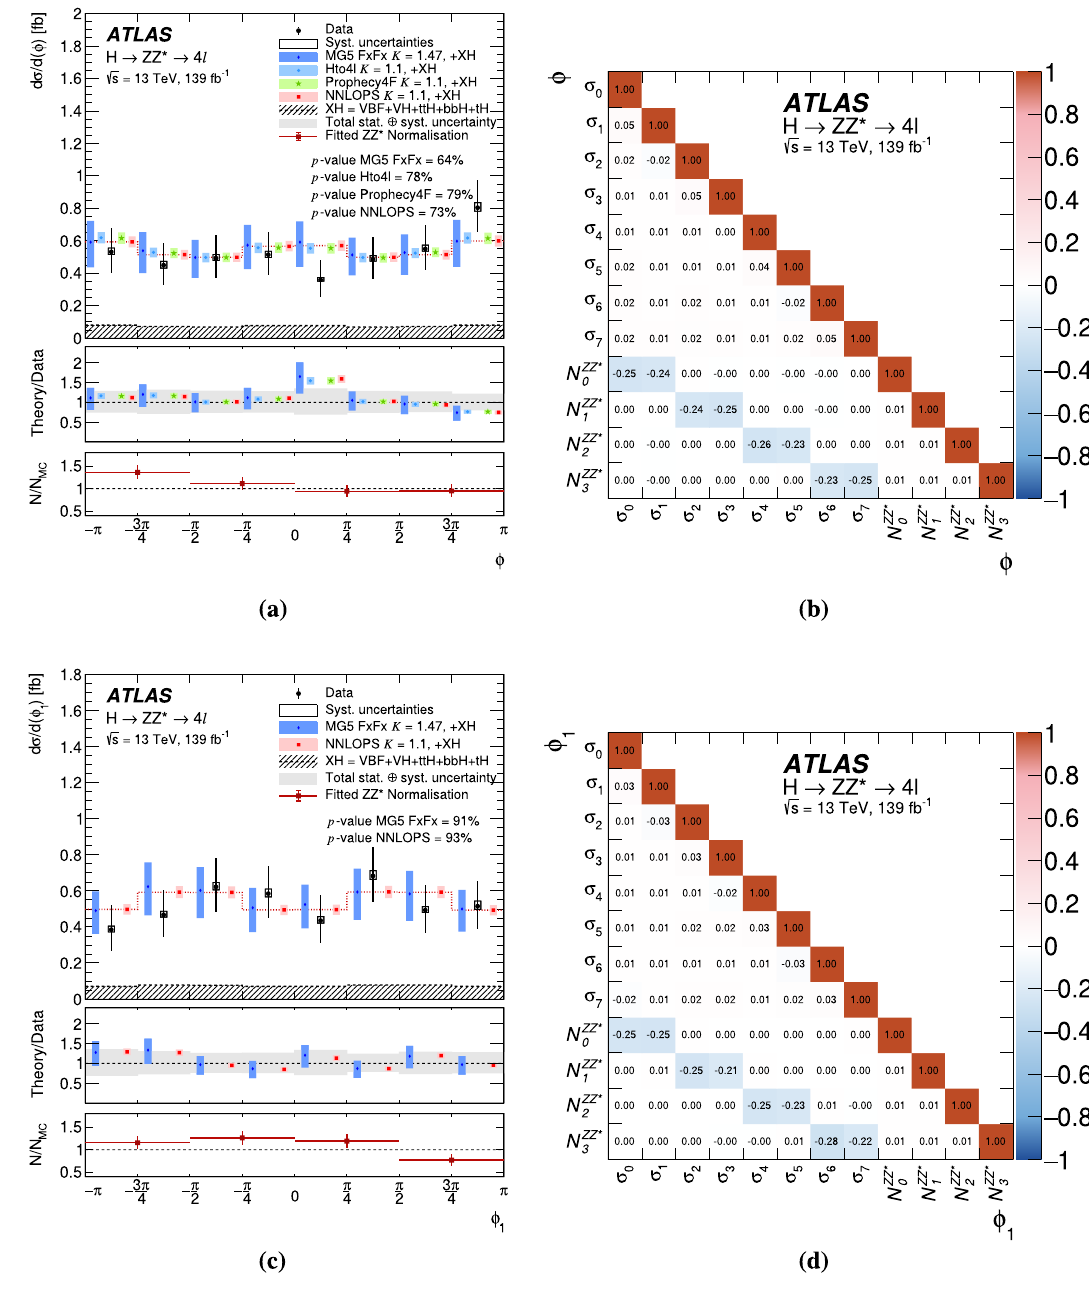
Fig. 23 Differential fiducial cross sections for a the azimuthal angle, φ , between the decay planes of the two reconstructed Z bosons and c theazimuthalangle, φ 1 ,betweenthedecayplaneoftheleading Z boson